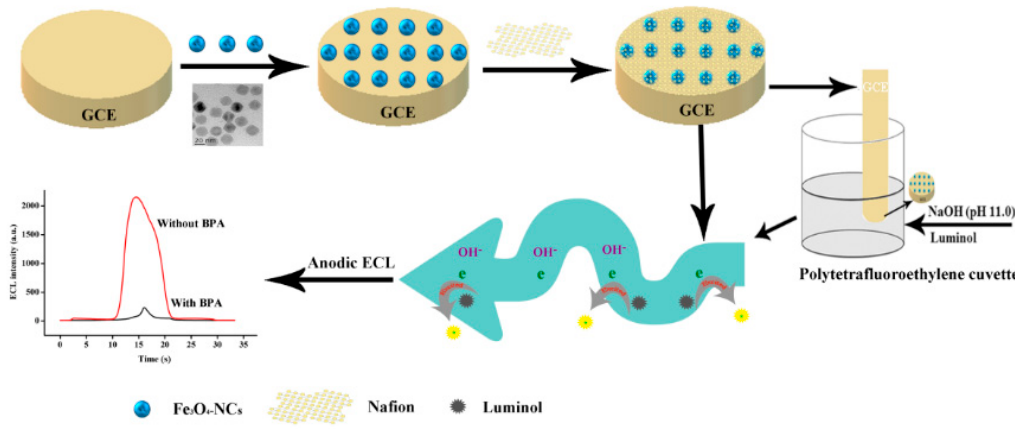
Figure 1. Schematic representation of ECL sensor development.